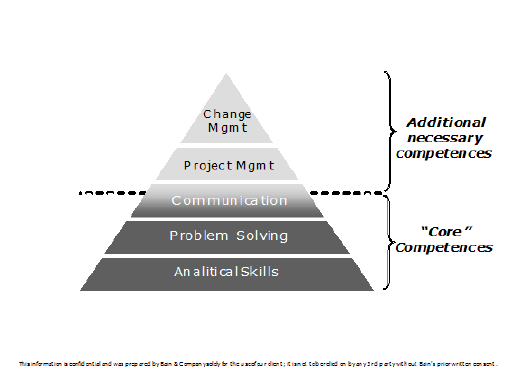
Figure 3 : Evolution of the Competence Required by